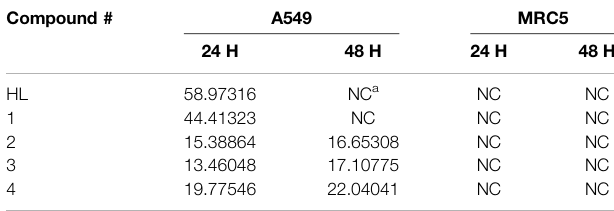
TABLE 3 | IC 50 values (µg/ml) of the selected compounds.